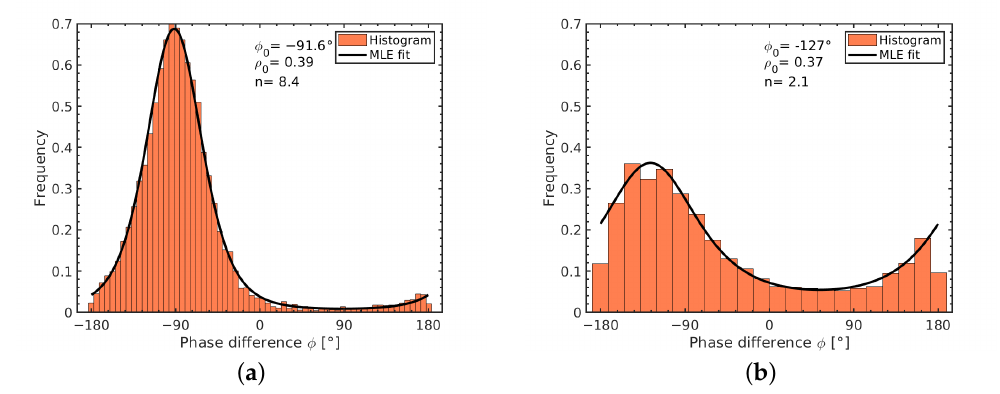
Figure 4. MLE fitting for speckled co-polarized phase difference histograms. ( a ) A 2.27-m-height corn field imaged by UAVSAR at incidence angle 49.98°. ( b ) A 2.00-m-eight corn field imaged by ALOS-2/PALSAR-2 at incidence angle